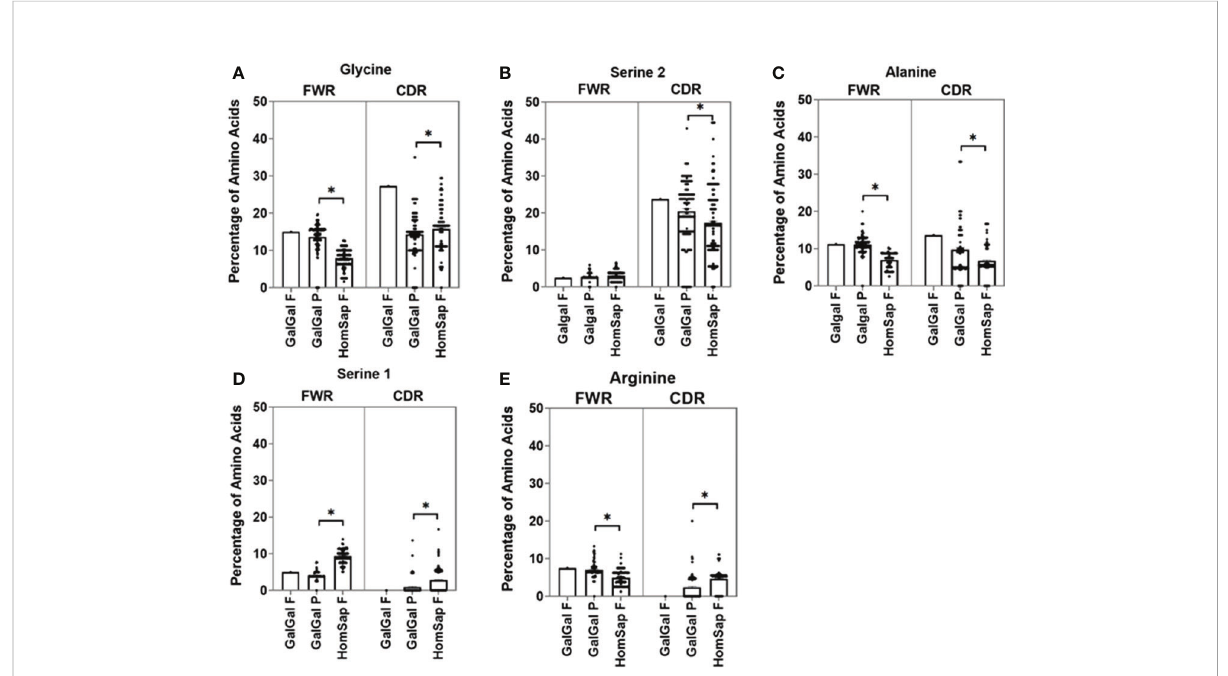
FIGURE 4 Comparison of amino acid usage across all three complementarity-determining regions (CDRs) of the heavy chain variable germline genes of both chickens and humans, displaying amino acid usage of (A) glycine, (B) serine 2 (AGY), (C) alanine, (D) serine 1 (TCN), and (E) Arginine. Datasets were statistically analysed using a one-way ANOVA. p-Values: *p ≤